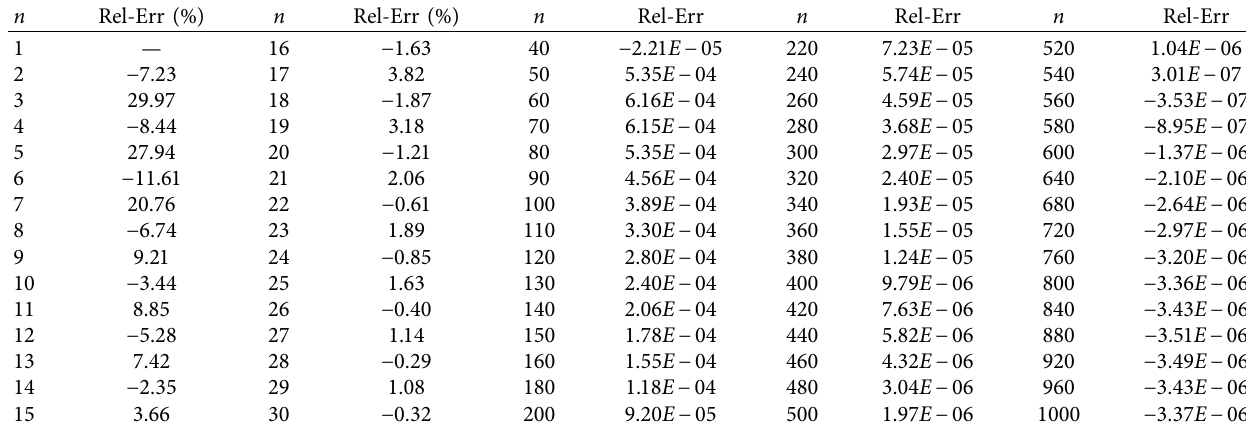
( n ) when 1000 ≤ n ≤ 10000, step 300. g 1 ( n ) to h ( n ) when n ≤ 1000. g 1